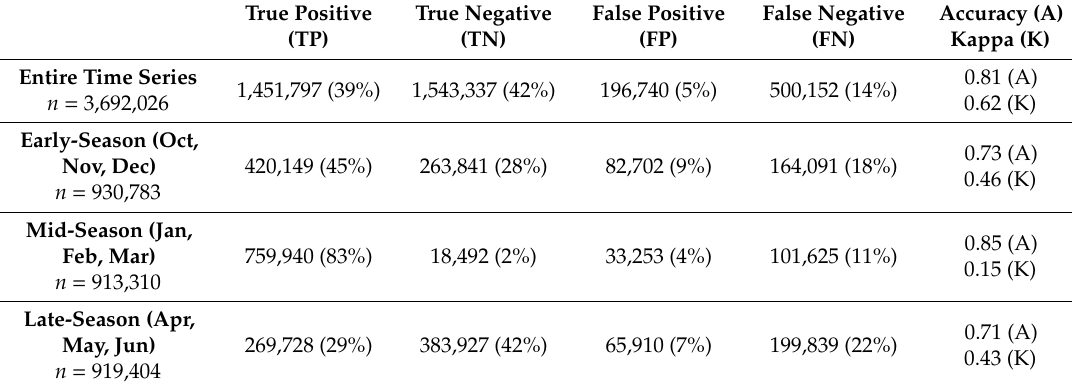
Table 3. Confusion matrix analysis to quantify the identification of the presence or absence of snow at all SNOTEL station locations during the assessment time period (2000–2018). The actual values are the SNOTEL dataset and the predicted values are the GEE dataset. Percentages are included for each value because of the large n values. The overall accuracy and the Kappa Coe ffi cient are included for each